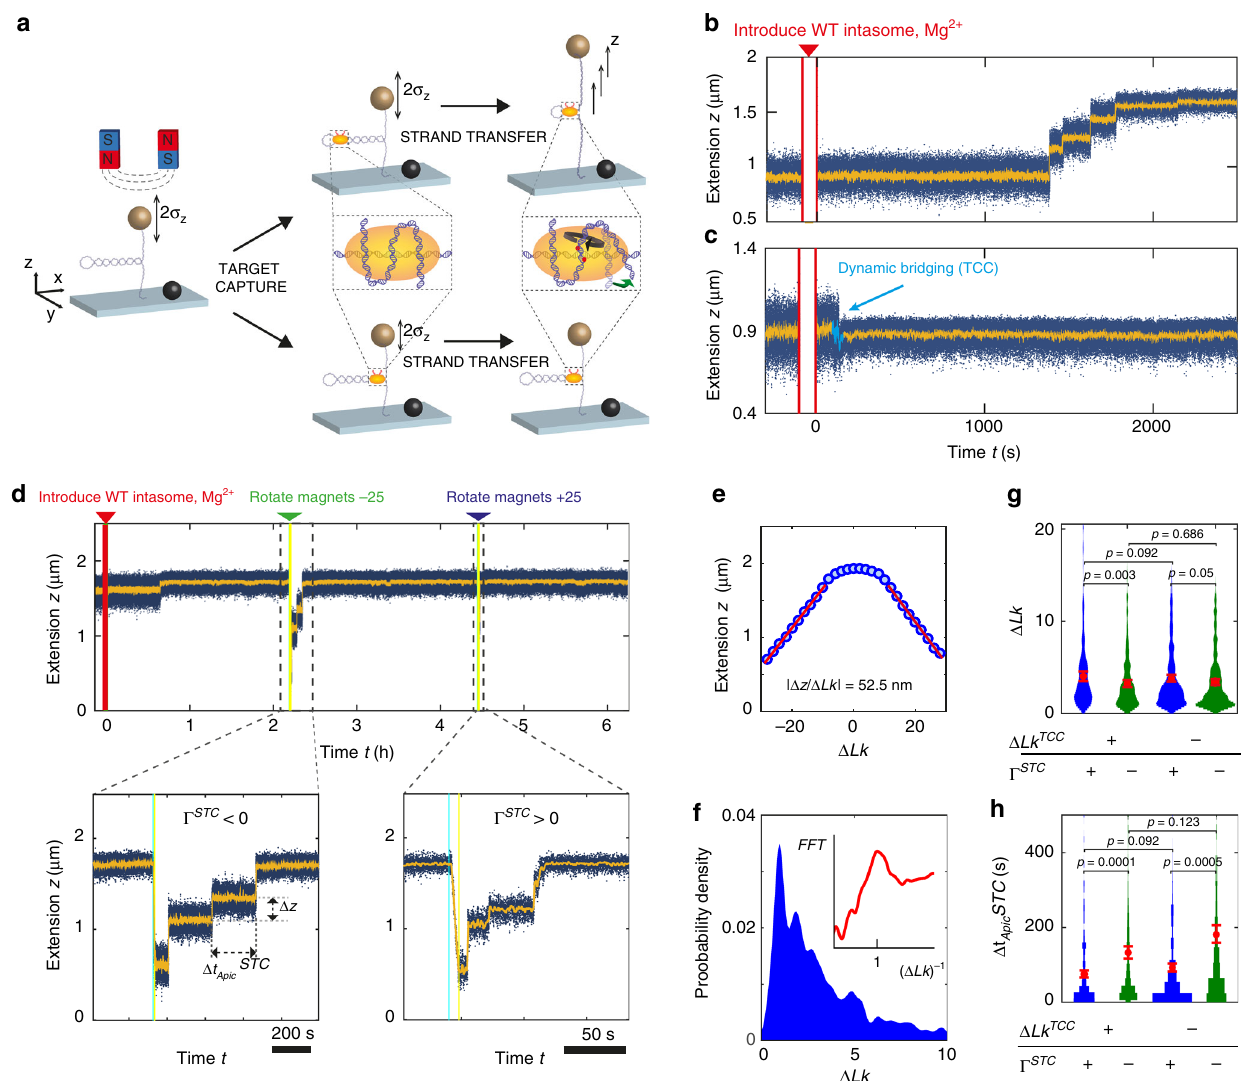
Fig. 4 Real-time observation of strand transfer and apical interface stability in STCs. a Scheme depicting signatures of strand transfer. Top: binding and reaction near plectoneme end loops minimally affect σ z but enables supercoil release through apical interface unbinding (green arrow) and rotational relaxation (black arrow). Bottom: binding near the origin of the plectoneme suppresses σ z , strand transfer quenches dynamic bridging by intasome-target anchoring. b , c Extension time-traces of supercoiled target DNA reacting with intasome, depicting stepwise extension increments ( b ) and extension hopping followed by a stable extension level ( c ). d Extension time-trace of supercoiled target DNA reacting with WT intasome. External magnets introduce supercoils that are released in steps due to transient apical interface unbinding. Extension plateaus quantify dwell times Δ t Apic STC , step sizes Δ z quantify extension increments. e In the plectonemic regime, the number of turns released per unbinding event Δ Lk is proportional to Δ z . f Δ Lk distribution (kernel density estimate; bandwidth 0.2 turns). Inset: Fourier transformation after subtracting an exponential background. g Dependence of step size Δ Lk distribution on the sign of Δ Lk TCC in TCCs and on the sign of the torque Γ STC applied to STCs (red data points are mean < Δ Lk > and error bars are 95% CI as obtained from an exponential fi t; Supplementary Fig. 7). h Dependence of dwell times Δ t Apic STC on Δ Lk TCC and Γ STC (red data points are mean lifetime τ Apic STC and error bars are 95% CI as obtained from an exponential fi t; Supplementary Fig. 7). Signi fi cance calculated using two-sample Kolmogorov – Smirnov test ( n TCC + STC +